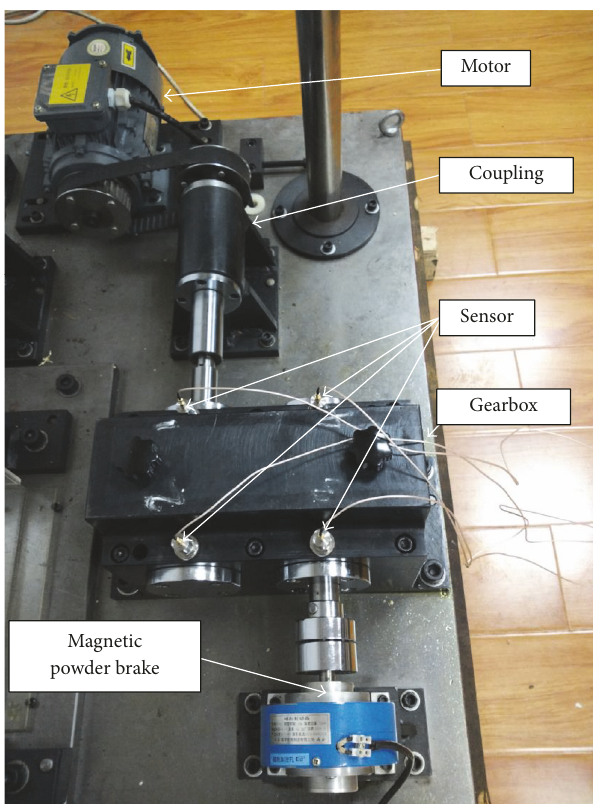
Figure 5: Experimental setup and sensor arranged.